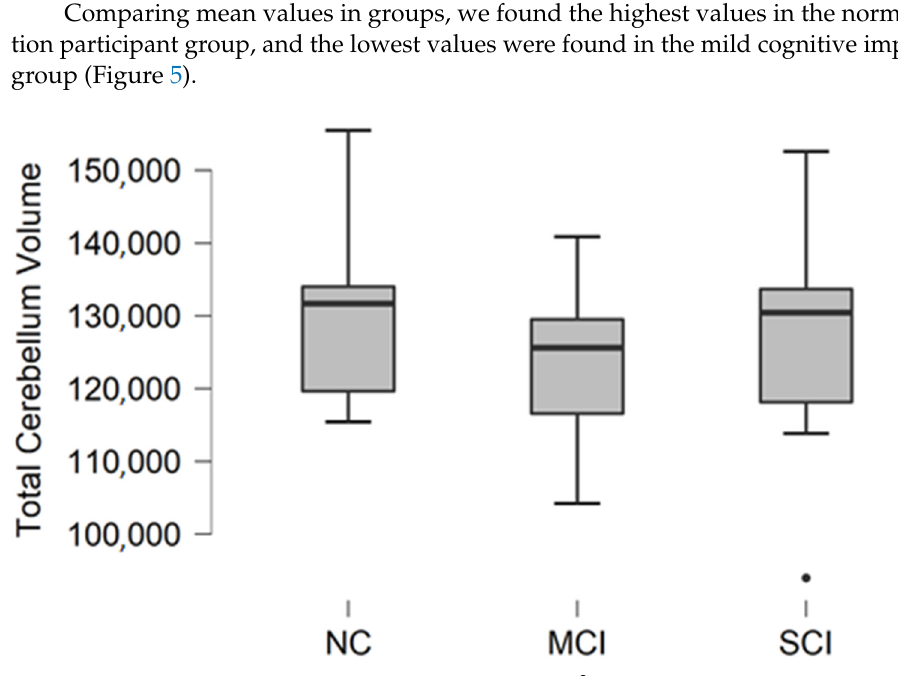
Figure 5. Mean total cerebellum volume values in mm 3 with standard deviation in participant groups. Black dots represent outliers (i.e., exceptionally diverging values).